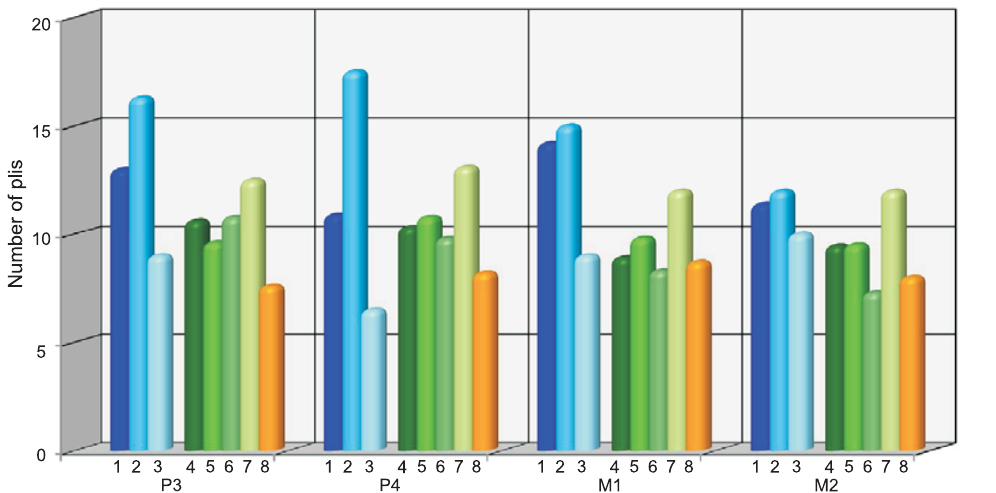
Fig.12. Plication number of the upper cheek teeth of Hipparion macedonicum from the various Greek localities.